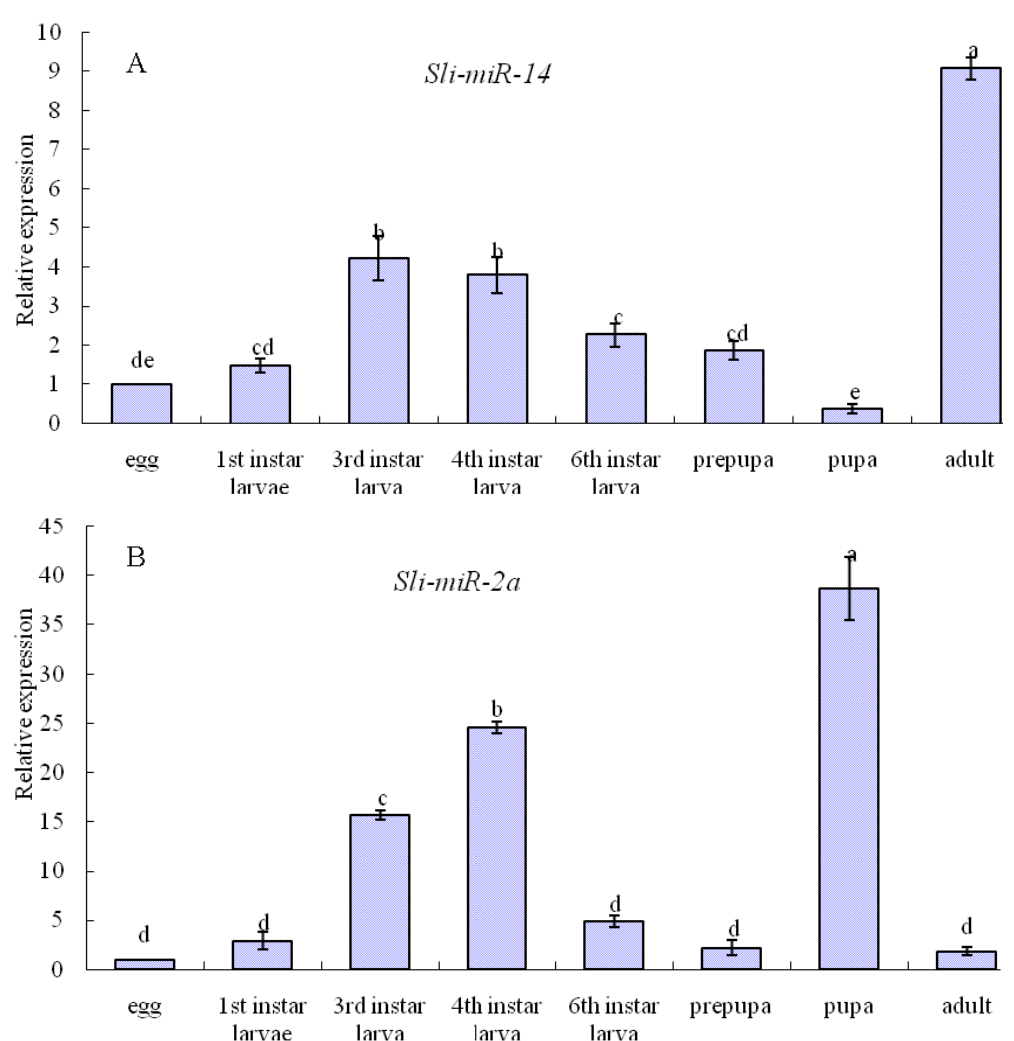
Figure 5. The relative expression levels of sli-miR-14 ( a ) and sli-miR-2a ( b ) in different developmental stages. Data are presented as means ± SE for three experimental replicates. Letters above each bar indicate expression significance in the different stages by Duncan’s Multiple Ranges